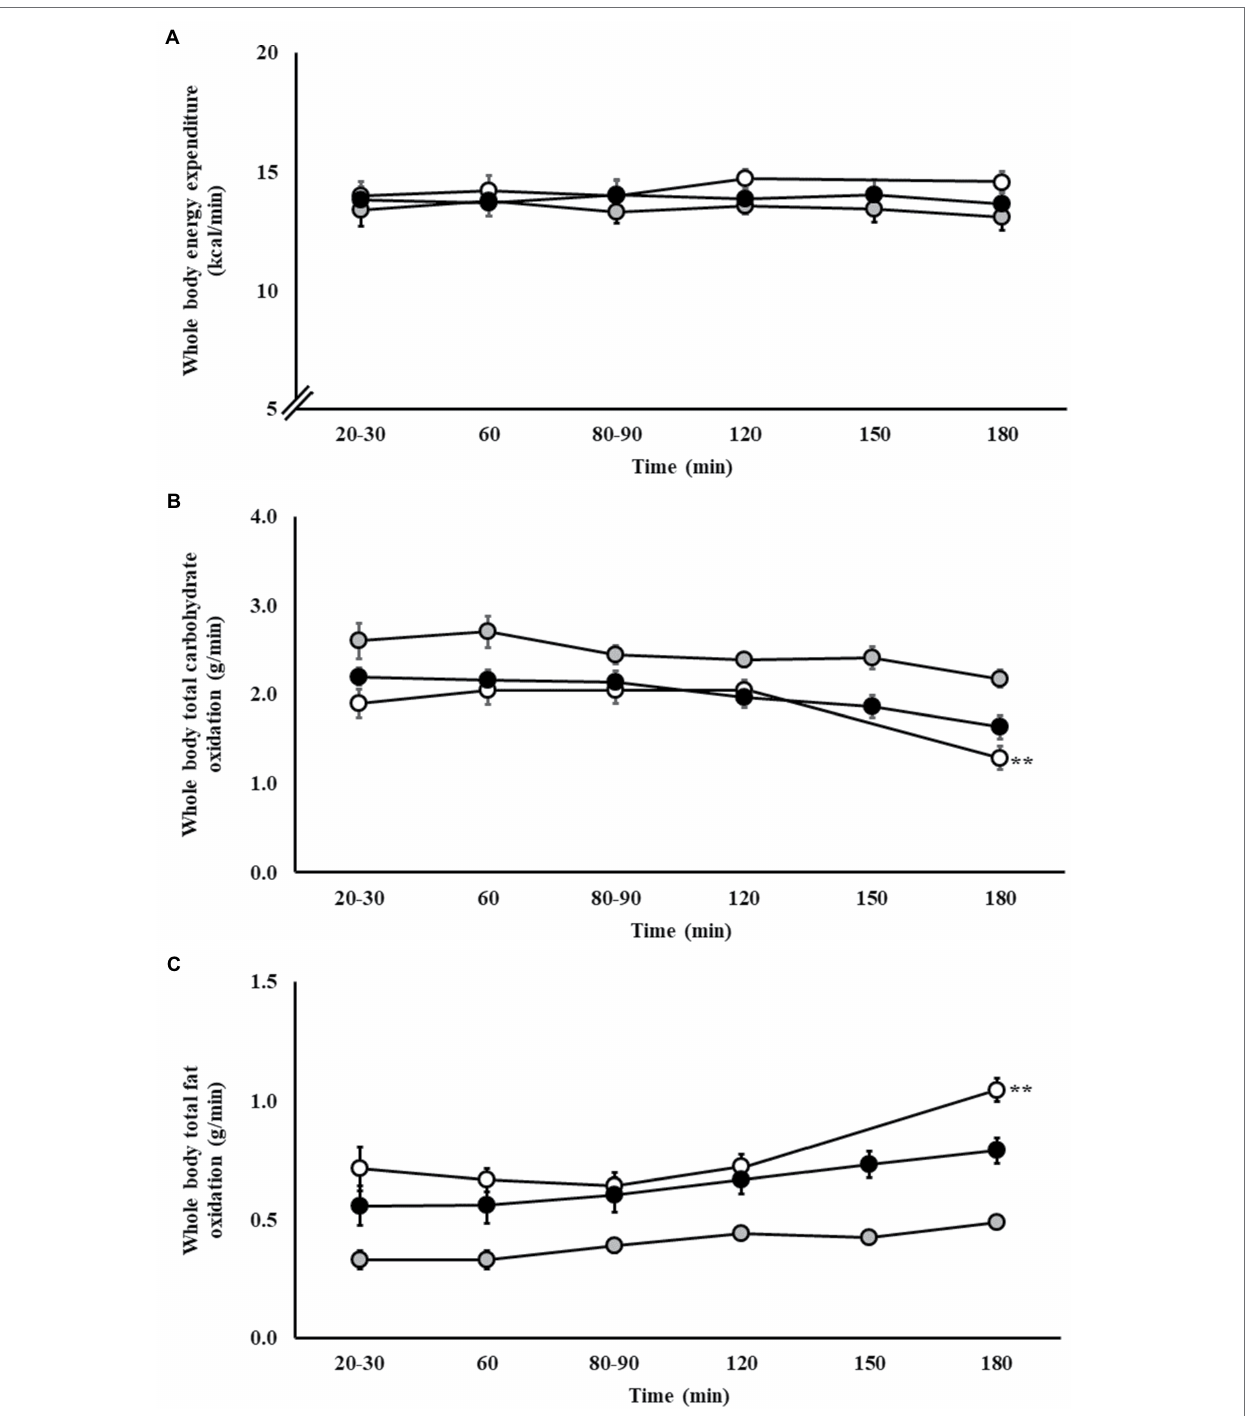
FIGURE 1 | Whole body energy expenditure (A) , total carbohydrate (B) and fat (C) oxidation rates during steady-state running with carbohydrate (CHO) provision on P1 ( ○ ), P2 ( ● ), and P3 ( ● ). Mean ± SEM ( n = 28): ** p < 0.01 vs. 20 min. P1: formulated gel-disc containing 30 g CHO with 300 ml water (10% w/v , 90 g/h, 2:1 glucose–fructose, 316 mOsmol/kg), at 0 min and every* 20 min thereafter for 120 min; followed by water provisions ad libitum for the 3rd h (270 ± 215 ml). Oxidation rates measured every 20 min for 120 min, then at 180 min. P2: CHO beverage containing 25 ± 3 g CHO (10% w/v , 76 ± 8 g/h, 509 mOsmol/kg; equivalent to 1.0 g/ kgBM/h) at 0 min and every 20 min thereafter for 120 min, then water provisions ad libitum for the 3rd h (170 ± 122 ml). Oxidation rates measured every 30 min for 180 min. P3: CHO beverage containing 45 g CHO (16% w/v , 90 g/h, 2:1 glucose–fructose, 460 mOsmol/kg), at 0 min and every 30 min thereafter for 180 min. Water provisioned ad libitum , but not consumed by participants (0 ± 0 ml). Oxidation rates measured every 30 min for 180